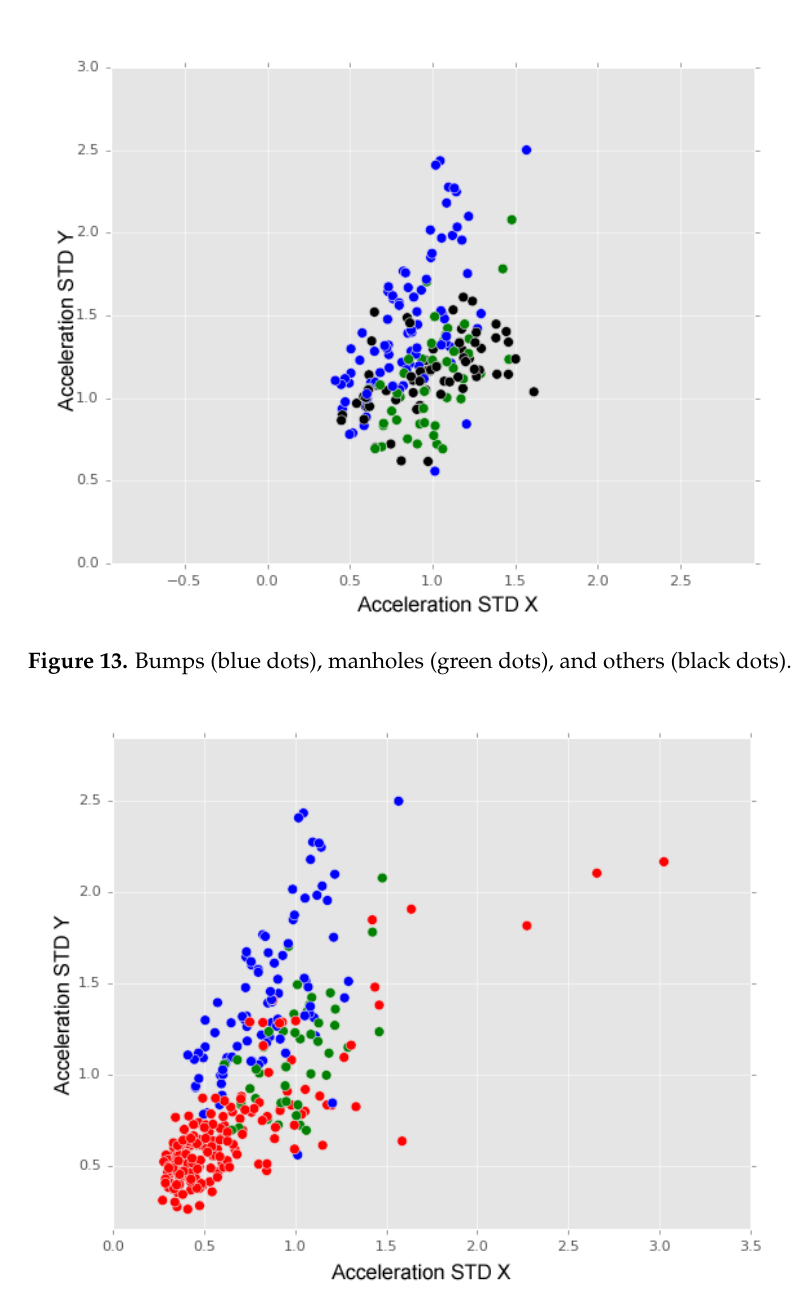
Figure 14. No anomalies (red dots), major anomalies (blue dots) and minor anomalies (green